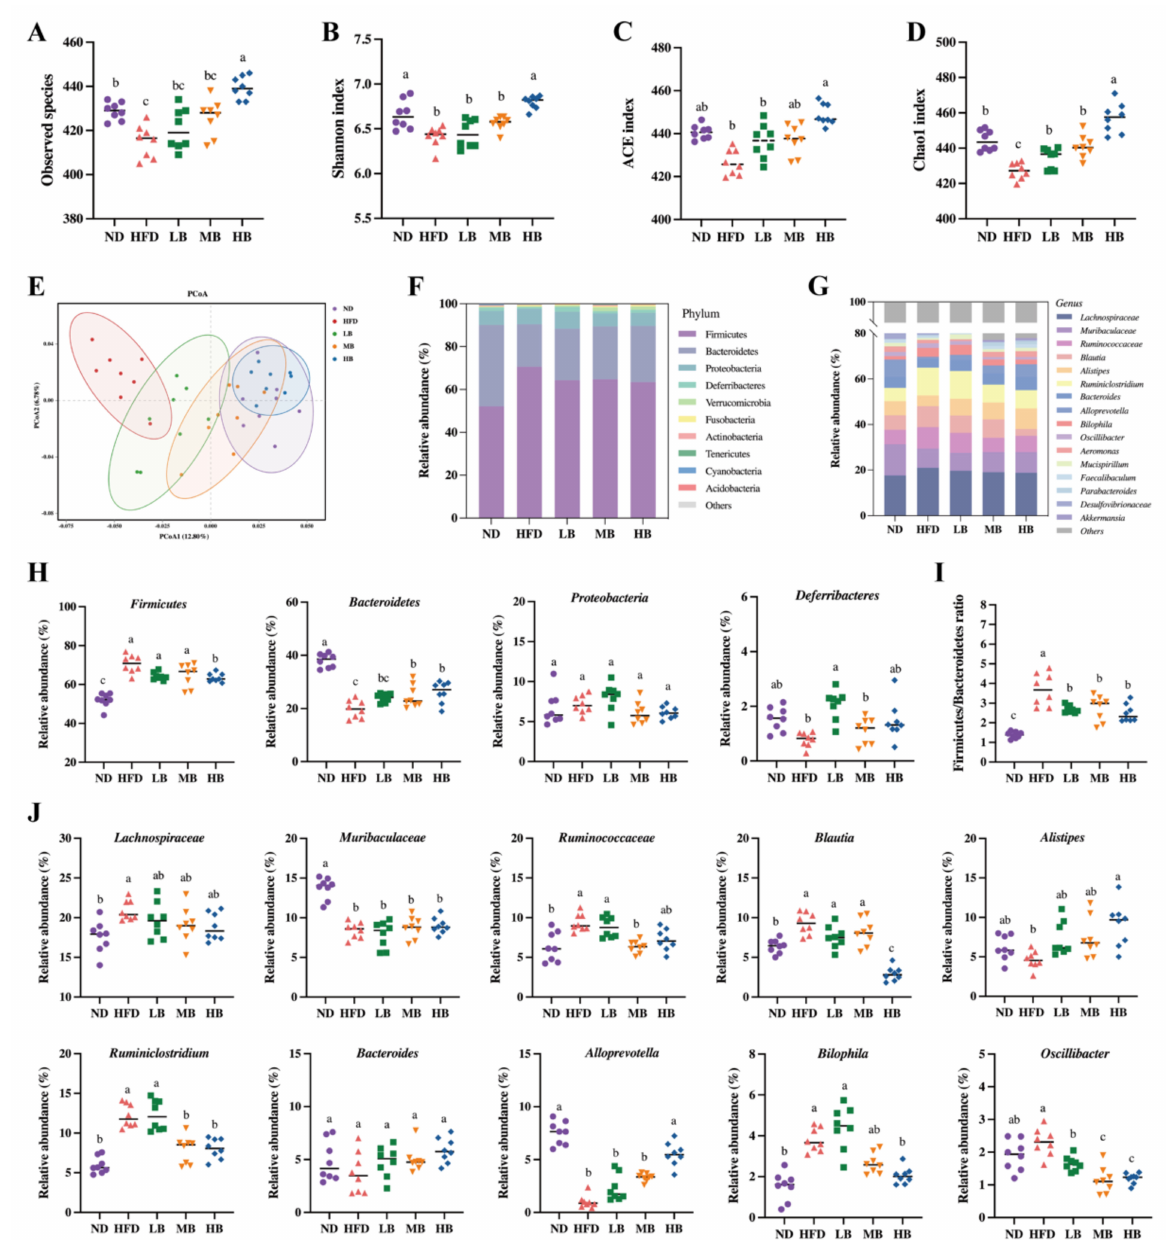
Figure 5. Effects of tartary buckwheat on gut microbial profile. ( A ) Observed species. ( B ) Shan- non index. ( C ) ACE index. ( D ) Chao1 index. ( E ) Weighted UniFrac PCoA. ( F ) The gut